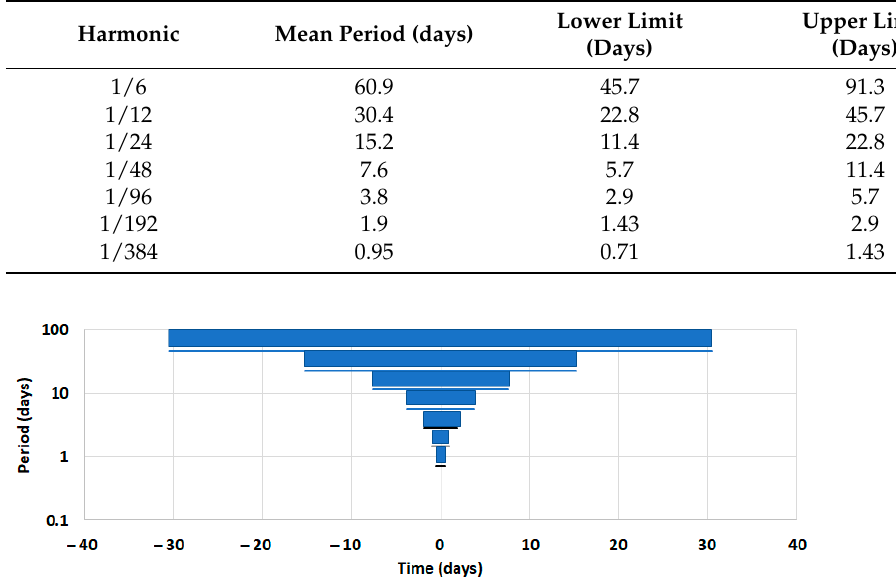
Figure 1. The bands in which the data are scale-averaged (the scale in the Morlet wavelet is the period) and, for an optimum representativity of the result, time-averaged over time intervals equal to the mean period. Time is centered on the date of occurrence of the extreme rainfall event. From the top to the bottom, the mean periods of the bands are harmonics 1/6, 1/12, 1/24, 1/48, 1/96, 1/192, and 1/384 of the period of the declination of the sun, i.e., 365.24 days.